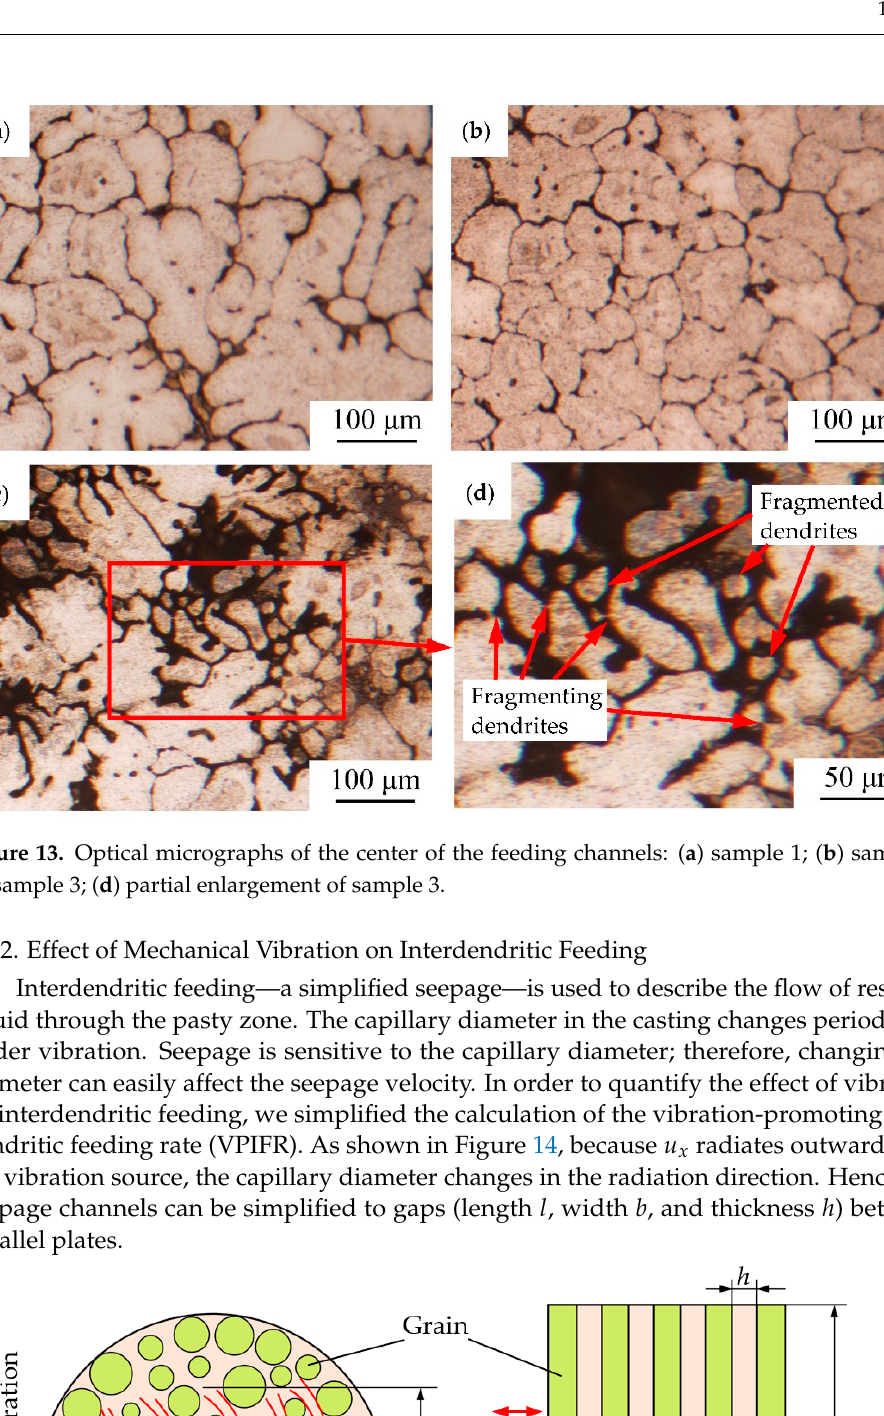
Figure 12. The shear strain of the feeding channel at 24% 𝑓 sc at 220 ms.